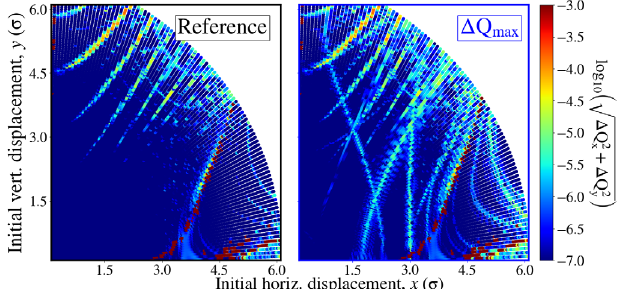
FIG. 12. The initial configuration space for the simulation parameters of Table II in the absence of power supply ripple (left) and including a tune modulation (right) with spectral components at 50, 150, 300, and 600 Hz with the maximum modulation depths Δ Q (Table max